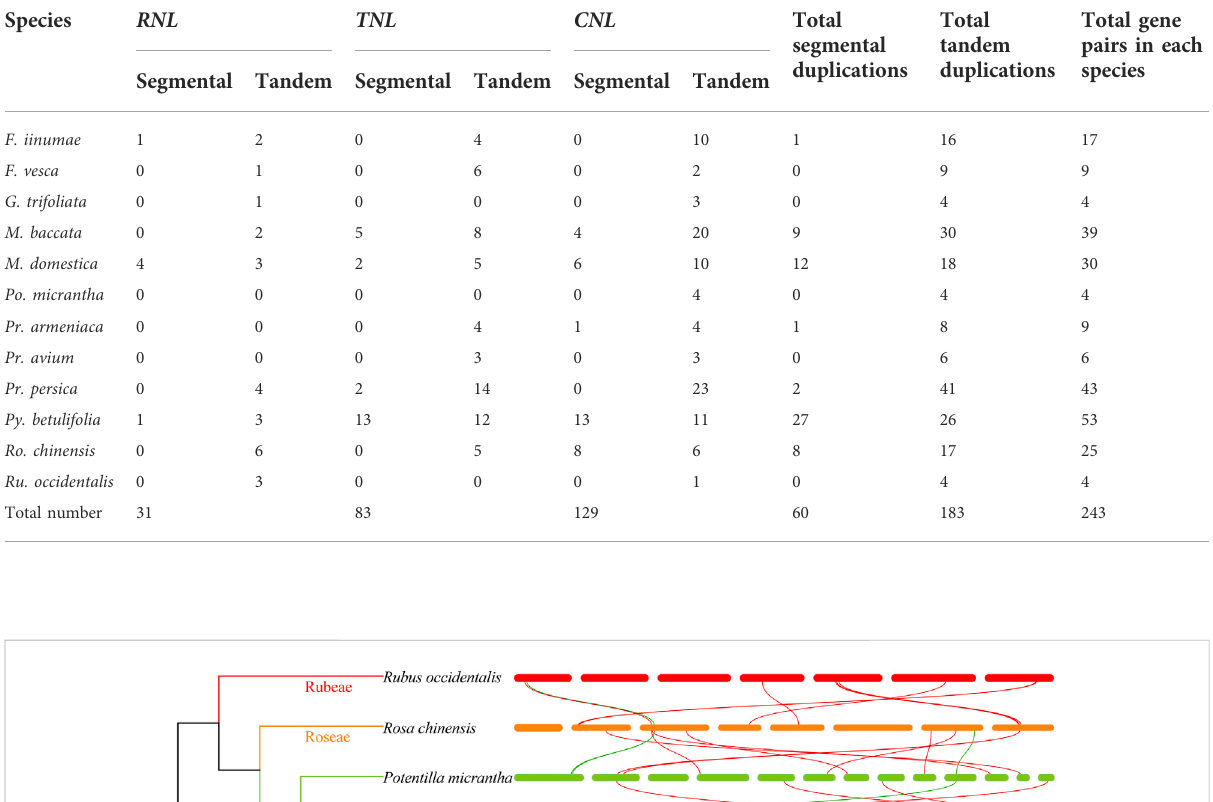
TABLE 2 Gene duplication types for NBS-LRR genes in 12 Rosaceae species.